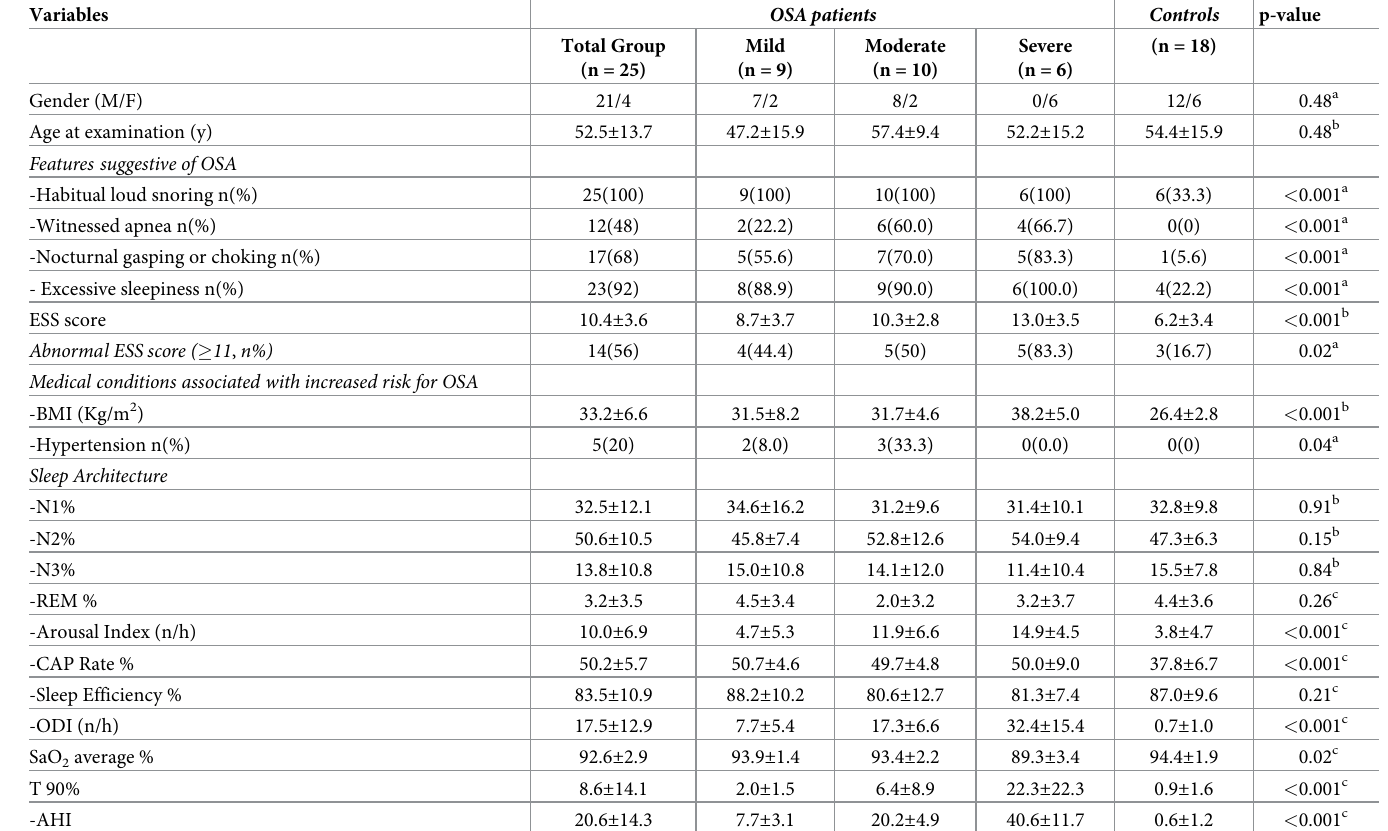
Table 1. Demographic, clinical and electrophysiological data in OSA patients and